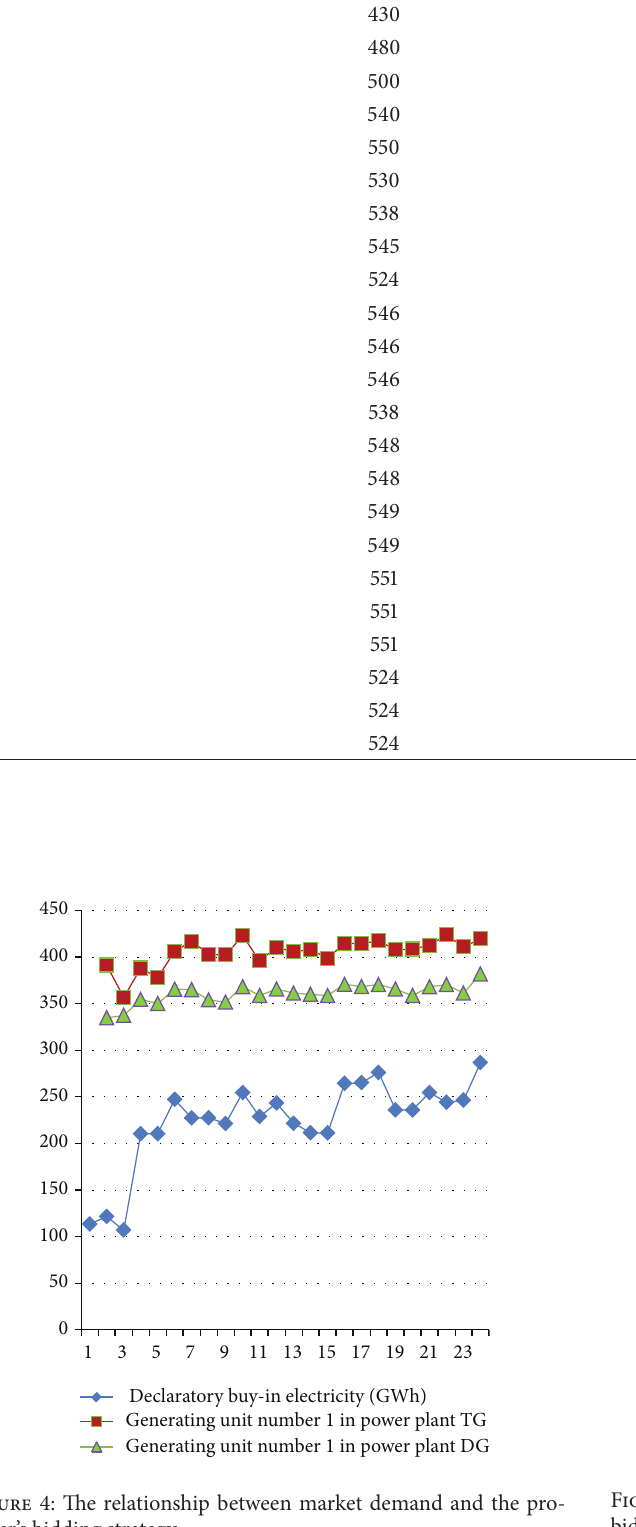
Figure 4: The relationship between market demand and the pro- ducer’s bidding strategy.